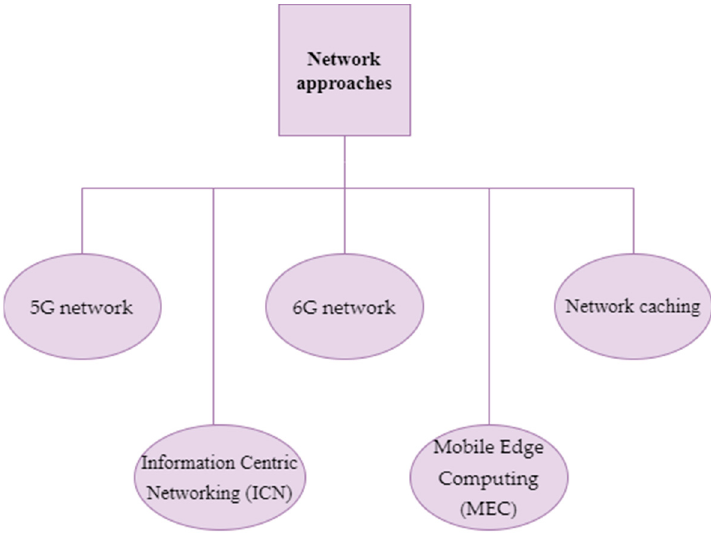
Figure 8. Network approaches to optimize 360-degree video streaming.